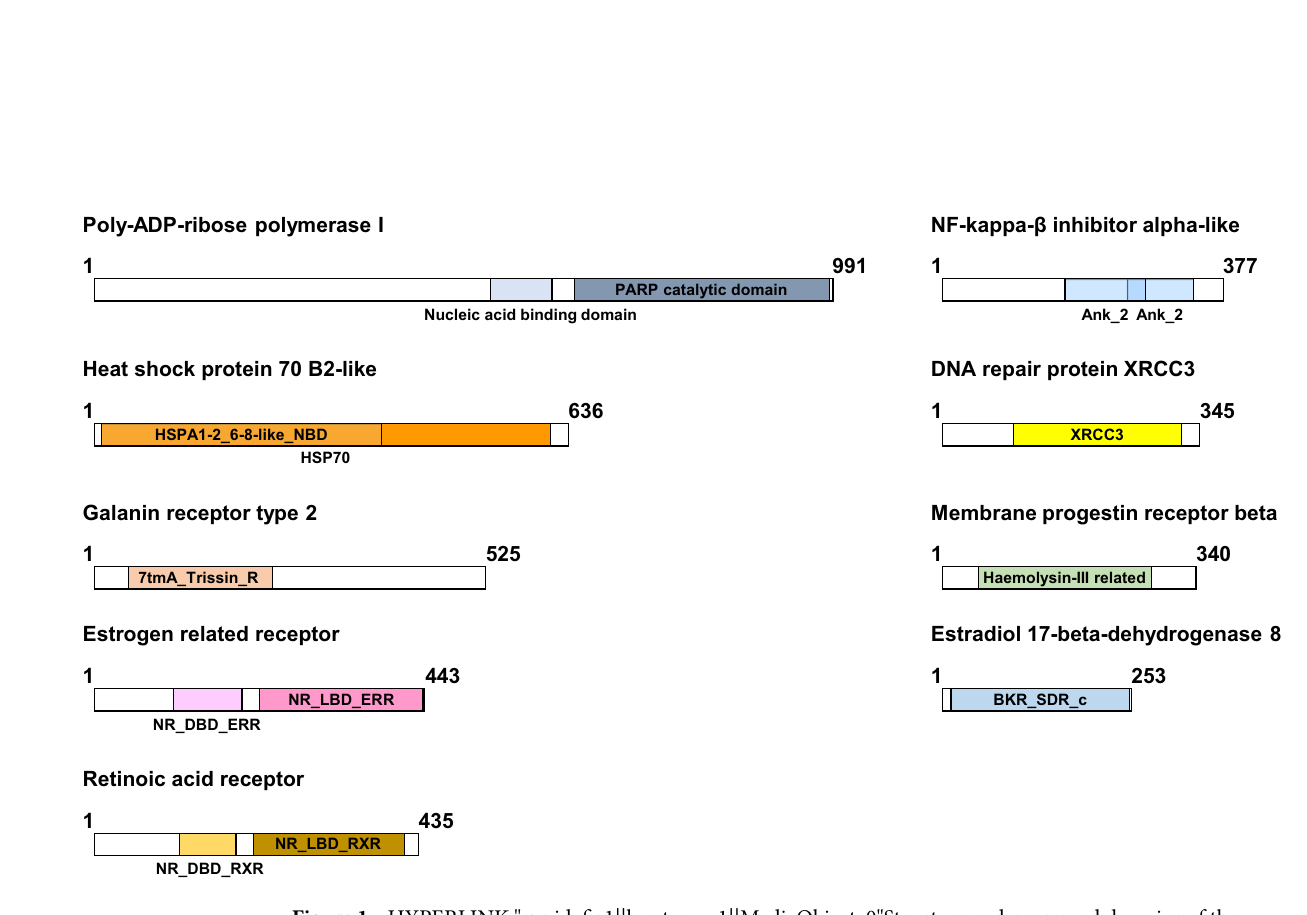
Figure 1. HYPERLINK "sps:id::fig1||locator::gr1||MediaObject::0"Structure and conserved domains of the Physella acuta proteins code by the sequences identified. The characteristic motifs of each protein are shown. The domains have been defined according to the Conserved Domains Database (CCD) functional classification of proteins. The size is indicated by the